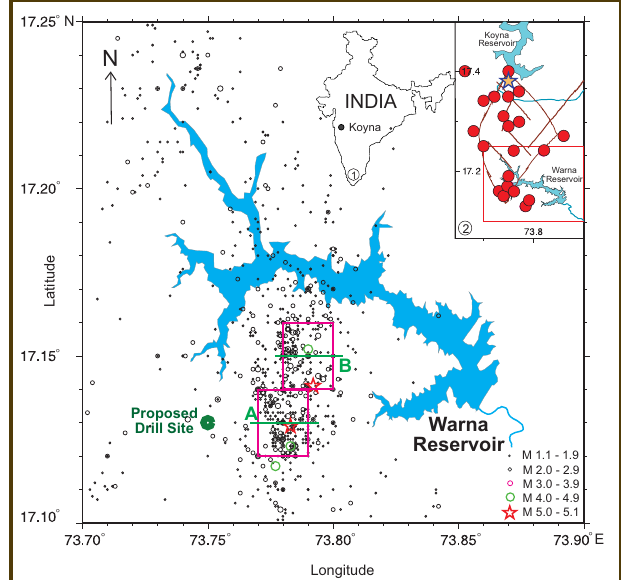
Figure 1. Seismicity in the Warna region south of Koyna, western India, during 2009–10 (red rectangle in inset 2). Inset 1: Map of India indicating the Koyna region; Inset 2: Earthquakes of magnitude 5 and above in the Koyna-Warna region since 1967.